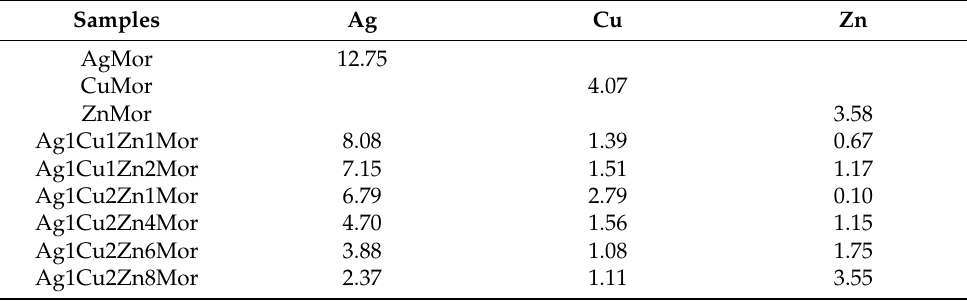
Table 1. Silver, copper, and zinc contents (wt.%) for exchanged samples.